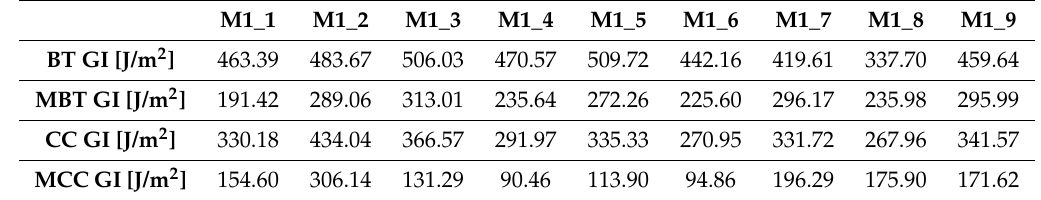
Table 3. Experimental delamination